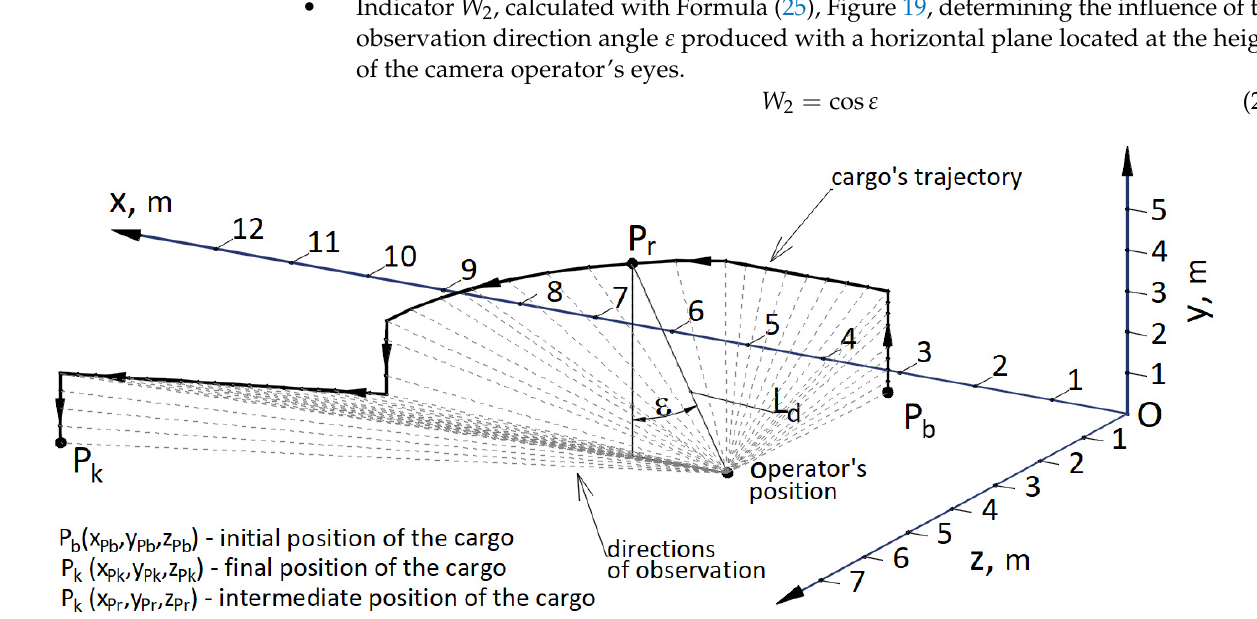
Figure 19. Calculation diagram for the indicator of the accuracy of positioning W sk , where: